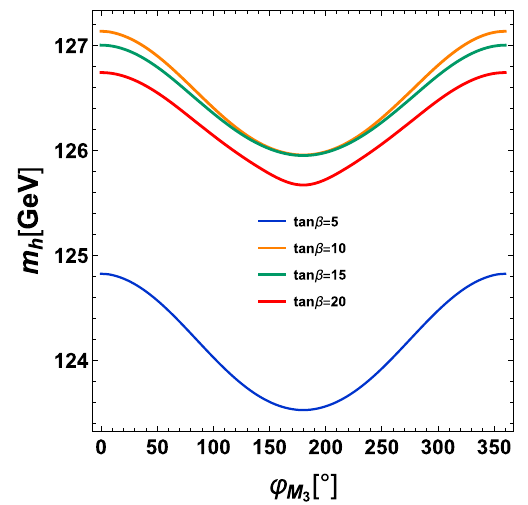
Fig. 6 Dependence of the mass of the lightest Higgs boson on the for a scenario with M H + = 500 GeV, ϕ A = 0, M s = 5 TeV, phase ϕ M 3 and | A | = | μ | = 3 M s